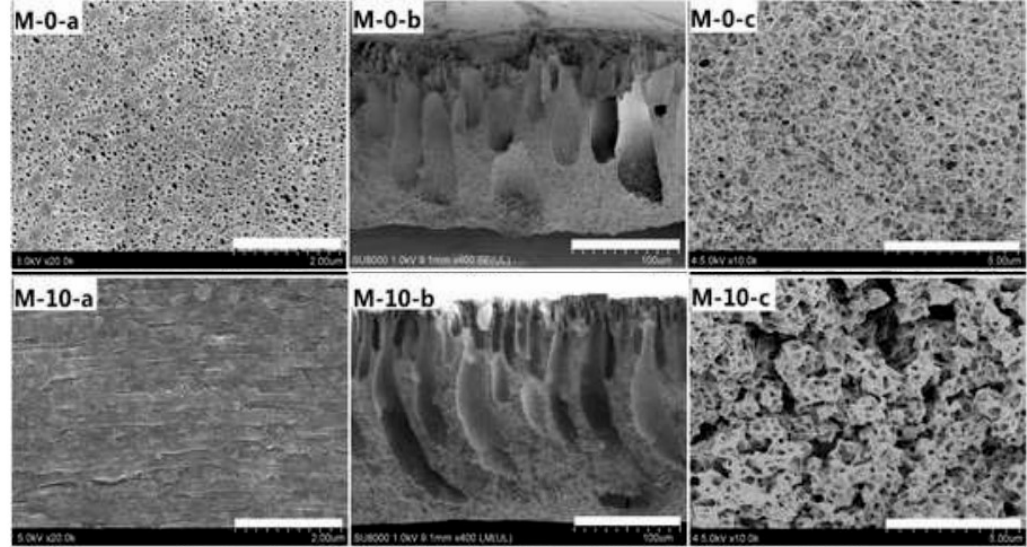
Figure 10. SEM images of PVDF / CNW composite membranes ( a ): surface; ( b ): cross-section; ( c ): enlargement of the rectangular area; (M-0-PVDF alone; M-10-PVDF + 10 wt % CNW) [72].